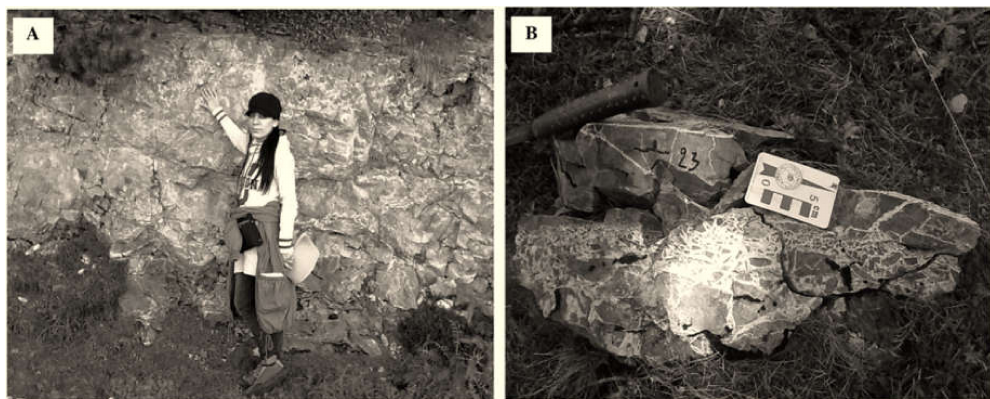
Figure 2. Triassic outcrops characterized by fractures arranged in horizontal and sub-vertical bands to the bedding planes, resulting in zebra-like structures ( A ), open fractures zones, and breccias ( B ).